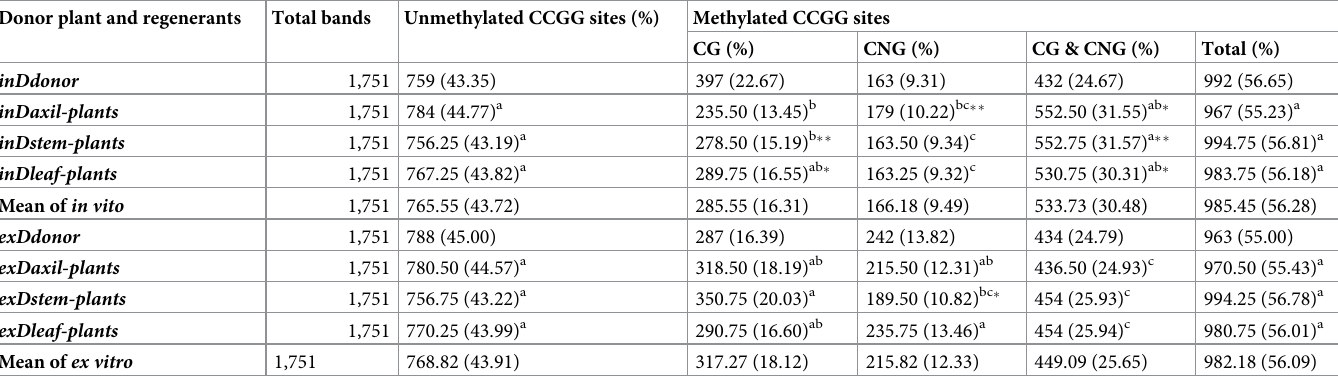
Table 2. Cytosine methylation level of L . ruthenicum D group based on MSAP analysis using 14 primer pairs. Donor plant and